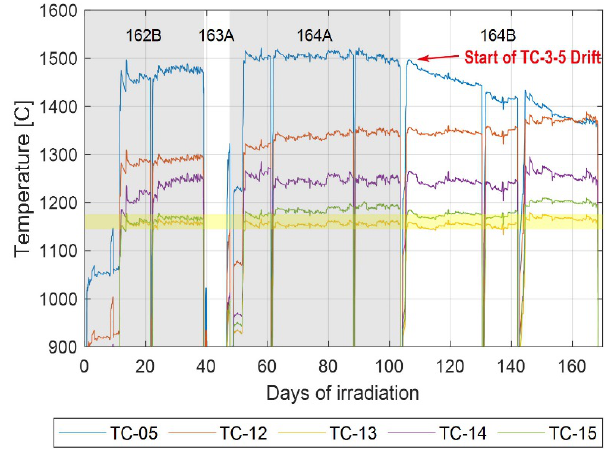
Fig. 7. Capsule 3 selected thermocouple